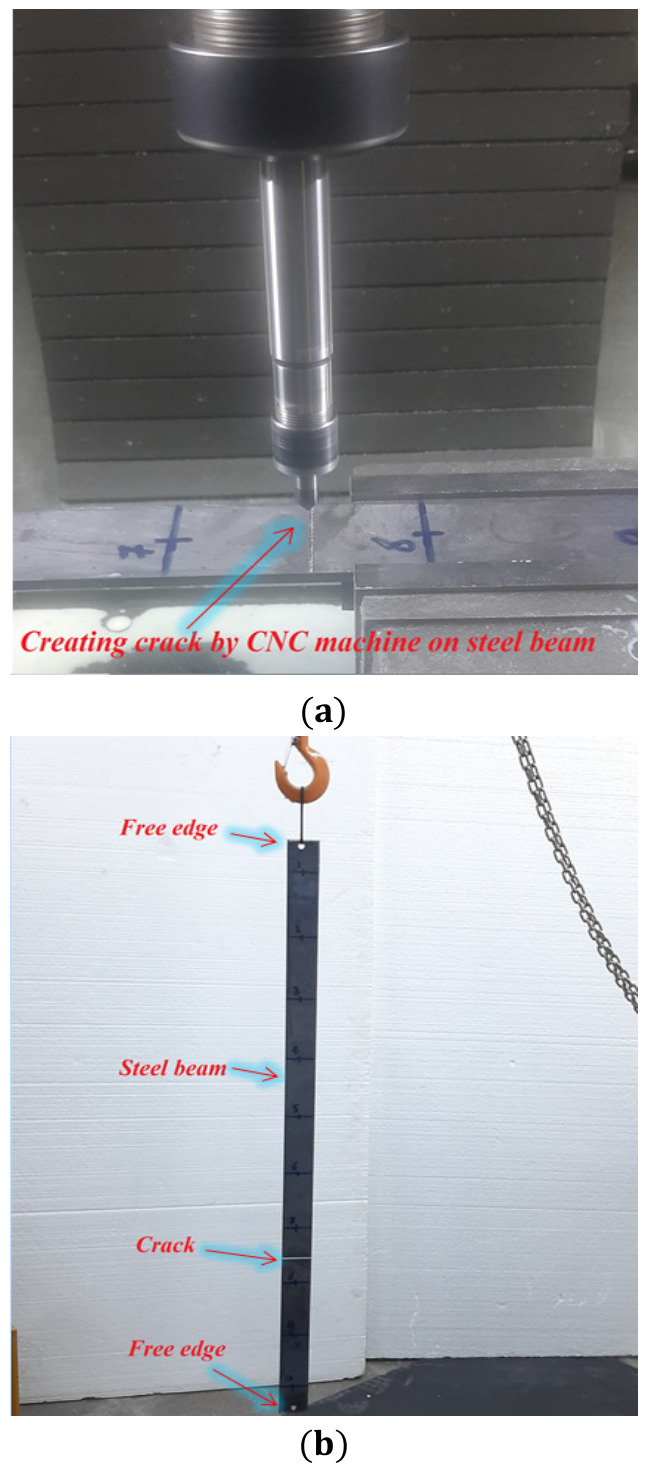
Figure 14. ( a ) Using CNC milling machining for creating damage on the steel beam, ( b ) the cracked Figure 14. ( 𝐚 ) Using CNC milling machining for creating damage on the steel beam, ( 𝐛 ) the cracked steel beam and its free-free boundary steel beam and its free-free boundary conditions.